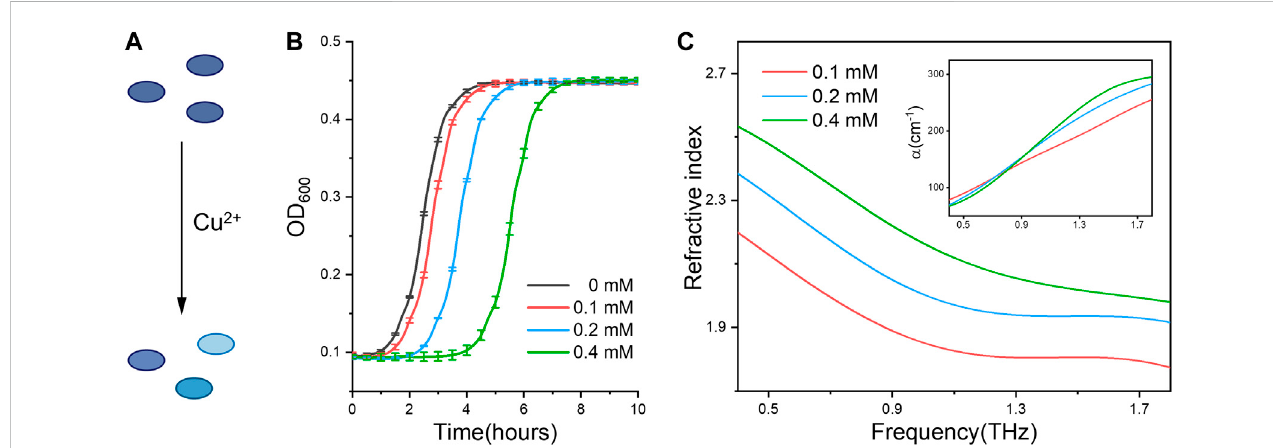
FIGURE 2 (A) Schematic showing Cu 2+ ions treatment induces distinct activity states of bacterial cells. (B) The growth curve of E. coli under 0, .1, .2 and .4 mM of Cu 2+ treatment, respectively. (C) Refractive index and absorption coef fi cient spectra (inset) of E. coli cells. All bacterial samples were treated with Cu 2+ and accounted to the same cell numbers for THz measurement.